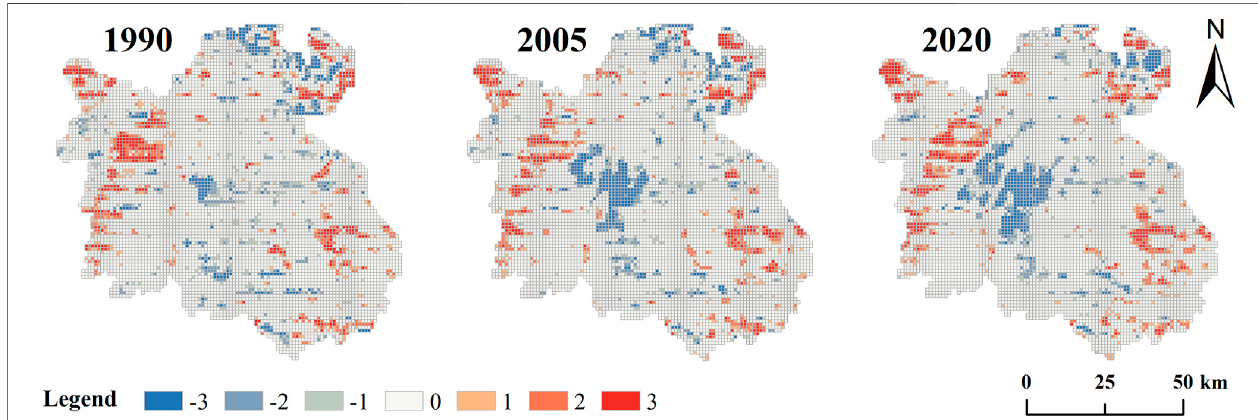
FIGURE 9 | Distribution patterns of cold/hot spots of ecosystem resilience in 1990, 2005, and 2020. Note: 3/3 represents the cold spot/hot spot with a 99% con fi dencelevel; − 2/2representsthecoldspot/hotspotwitha95%con fi dencelevel; − 1/1indicates thecoldspot/hotspotwitha90%con fi dencelevel;and0indicates no statistical signi fi